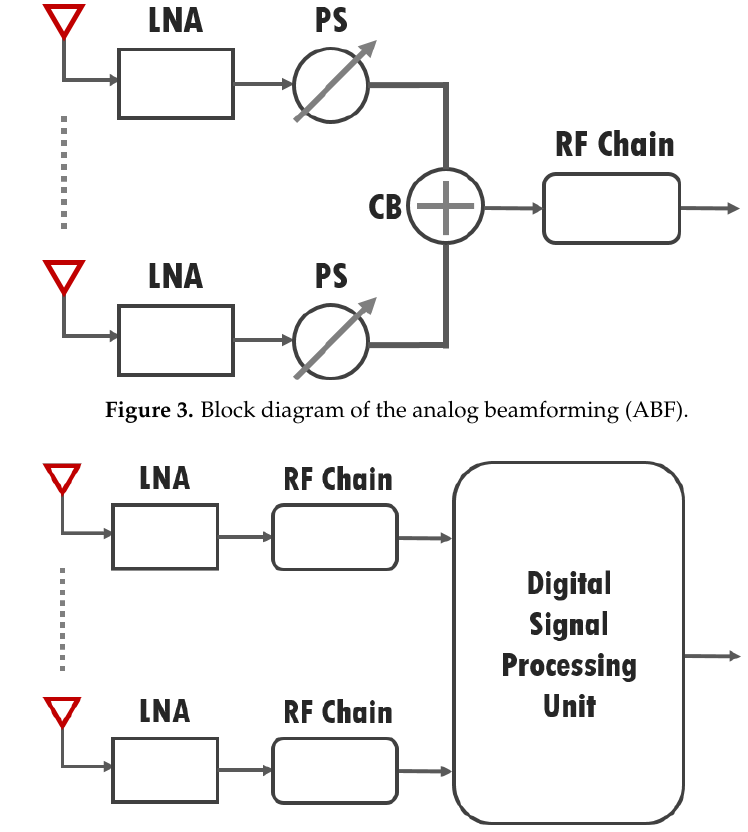
Figure 4. Block diagram of the digital beamforming